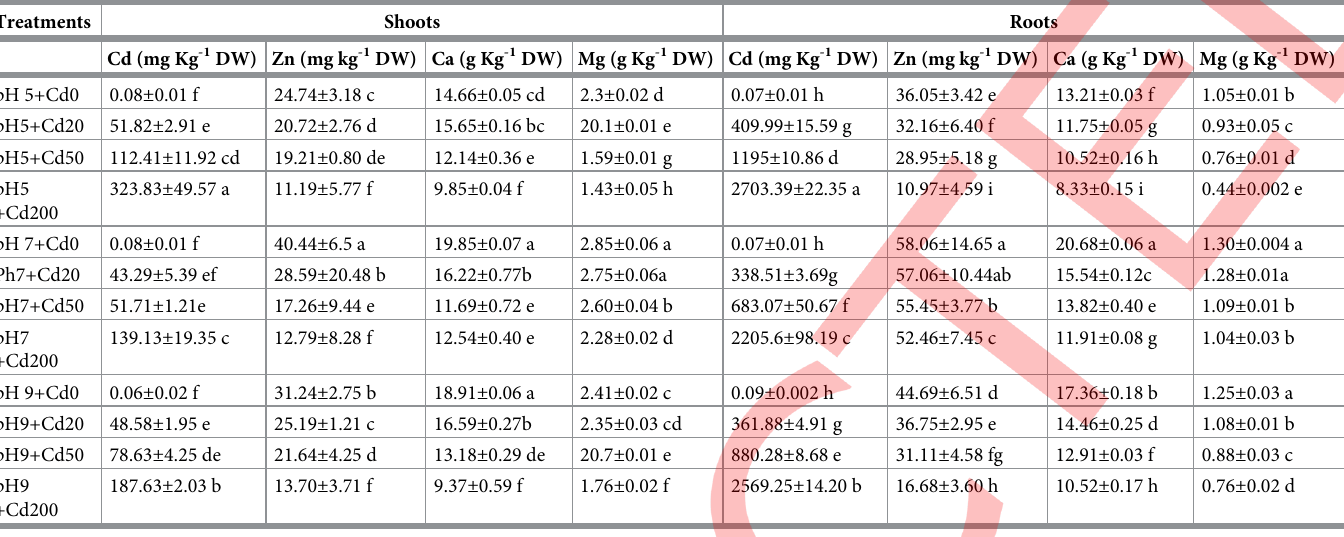
Table 2. Effect of pH and Cd on Cd, calcium (Ca), magnesium (Mg)), and zinc (Zn) contents in roots and shoots samples of the wheat plants grown under Cd-con- taminated growth media with three different levels of pHs. Treatments Shoots Roots